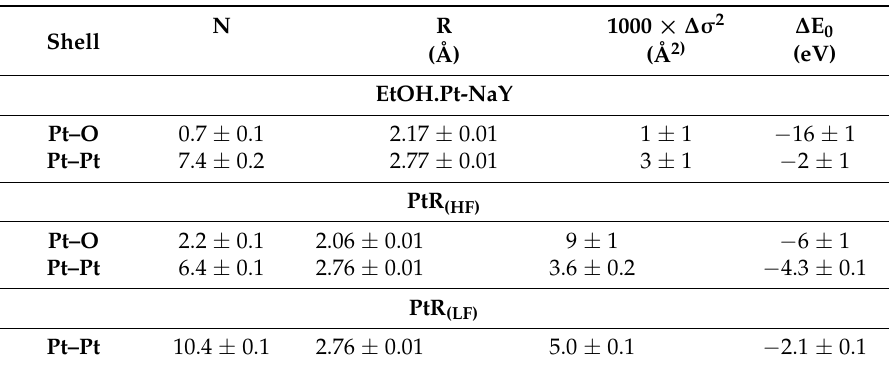
Table 3. Summary of EXAFS analysis